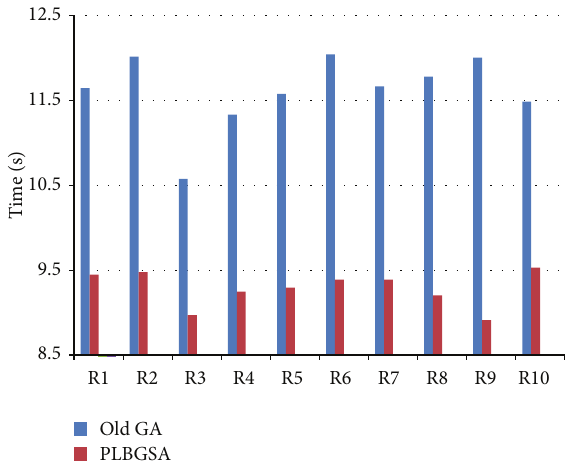
Figure 9: Ten runs of old GA and PLBGSA, with 𝑢 generations.